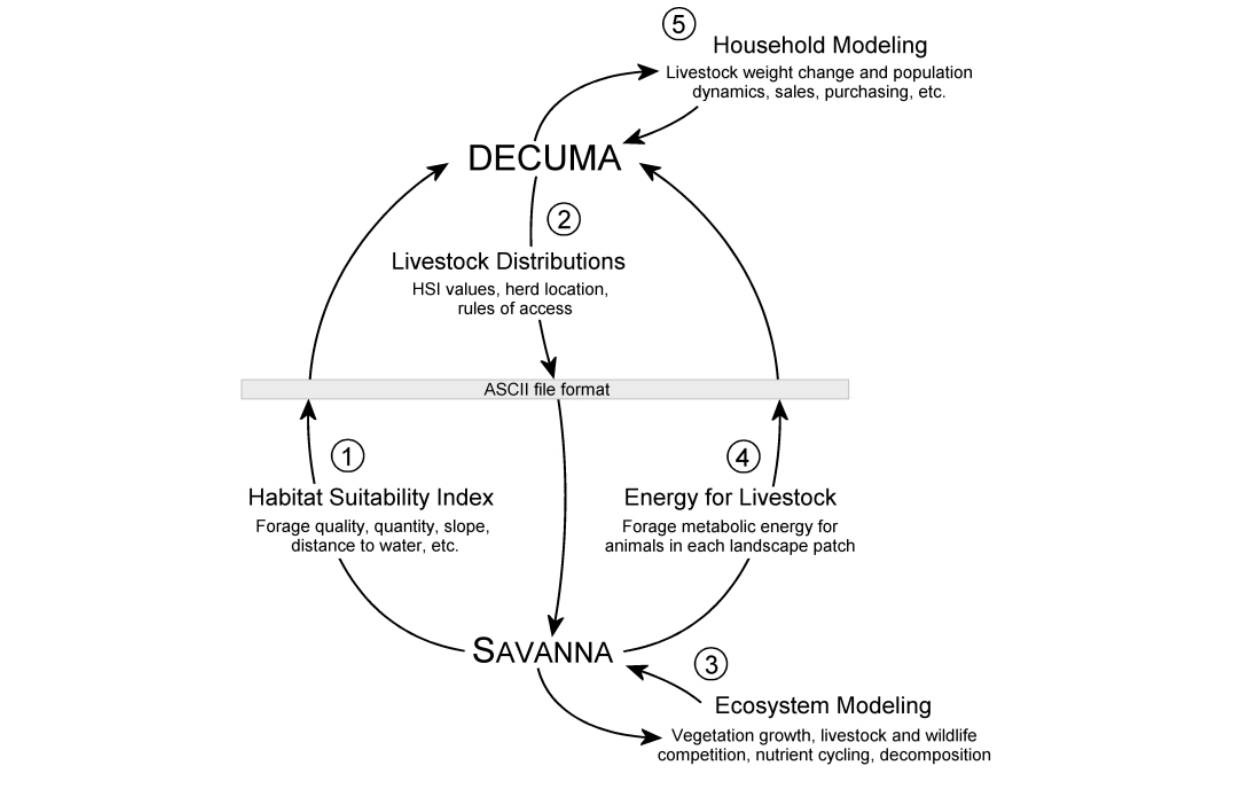
Fig. 3 . Detailed information flows between the household decision-making model DECUMA and the ecosystem model SAVANNA. Numbers are cited within the